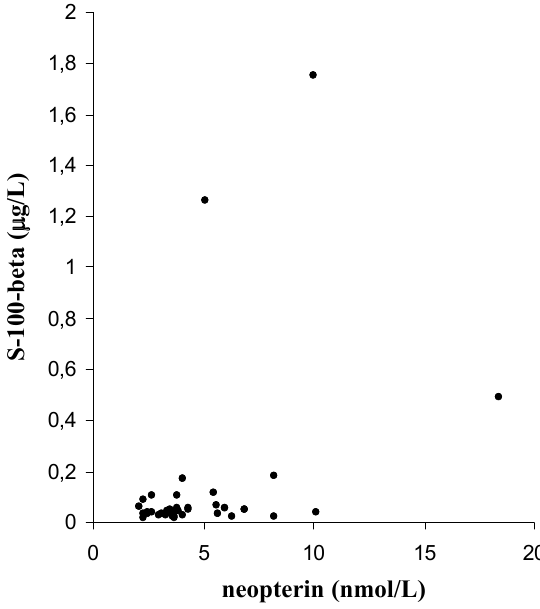
Figure 1 : Correlation between serum neopterin and S-100-beta concentrations in patients with malignant = 0.33, p < melanoma (r s